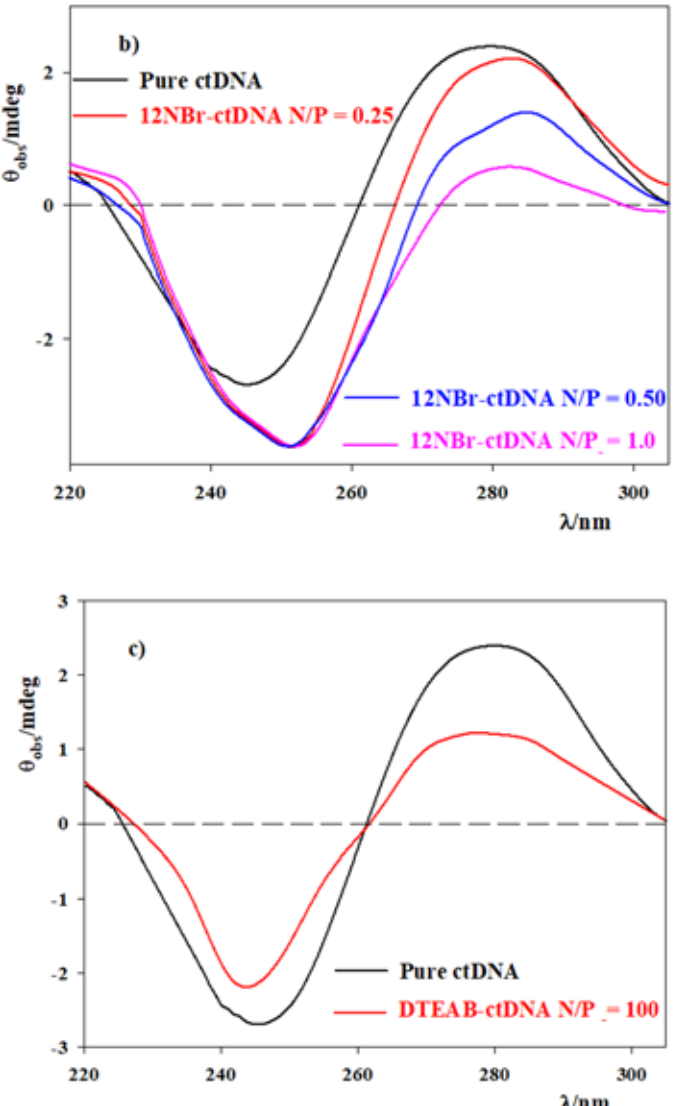
Figure 2. Dependence of the circular dichroism spectra of ctDNA (3.0 × 10 − 5 M) on the charge ratio N/P. The experimental values are expressed as the mean ± SD ( n = 9). Experimental conditions: [ctDNA] = 3.0 × 10 − 5 M, HEPES 10 mM (pH = 7.4) and T = 303.0 ± 0.1 K. ( a ) 12PhBr/ctDNA, ( b ) 12NBr/ctDNA and ( c ) DTEAB/ctDNA.